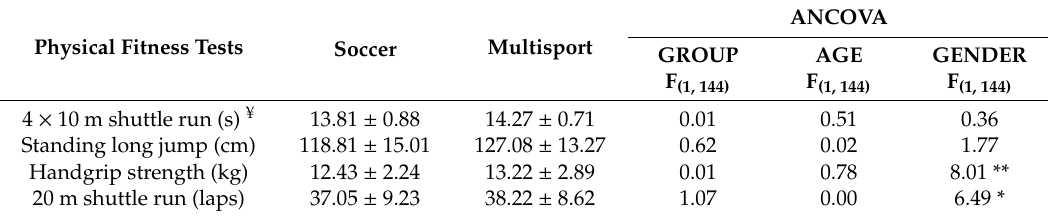
Table 3. Results of physical fitness tests in children engaged in soccer and